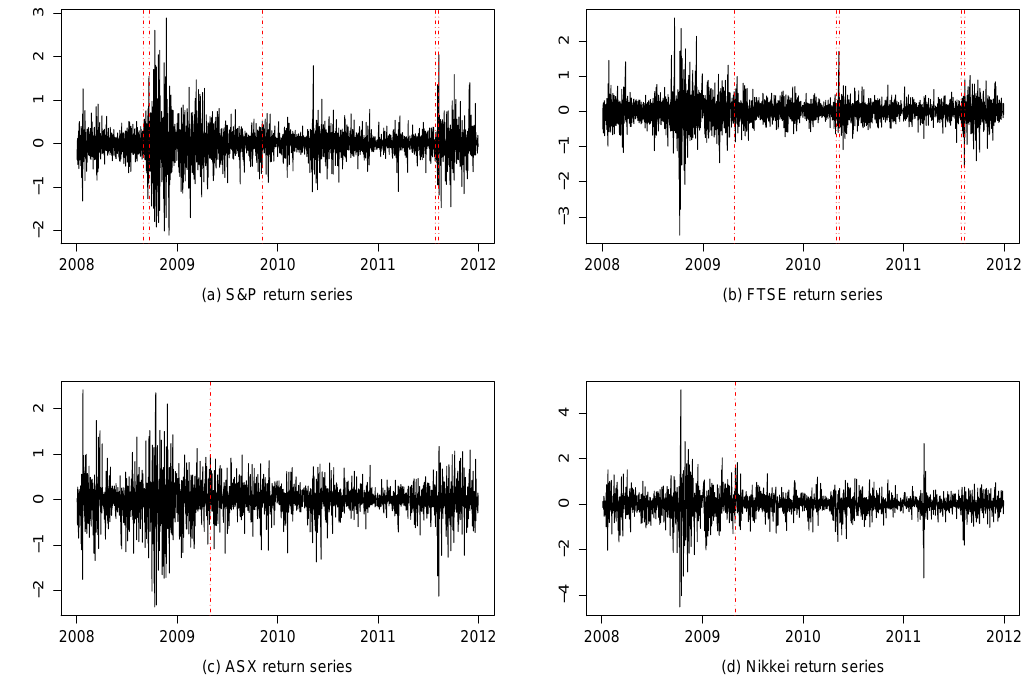
Figure 6. Identified structural change